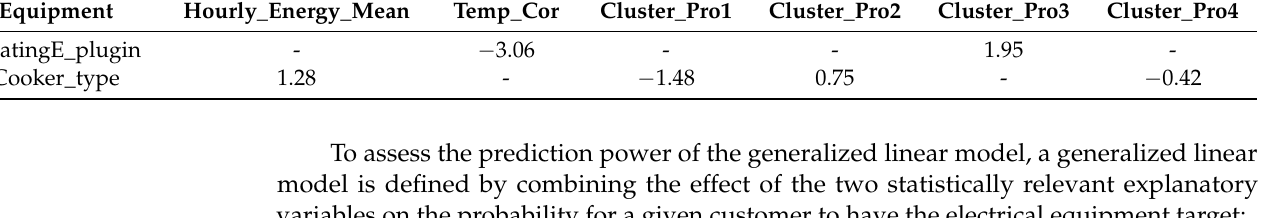
Table 3. β logistic regression coefficients for univariate models and p -value < 0.005.